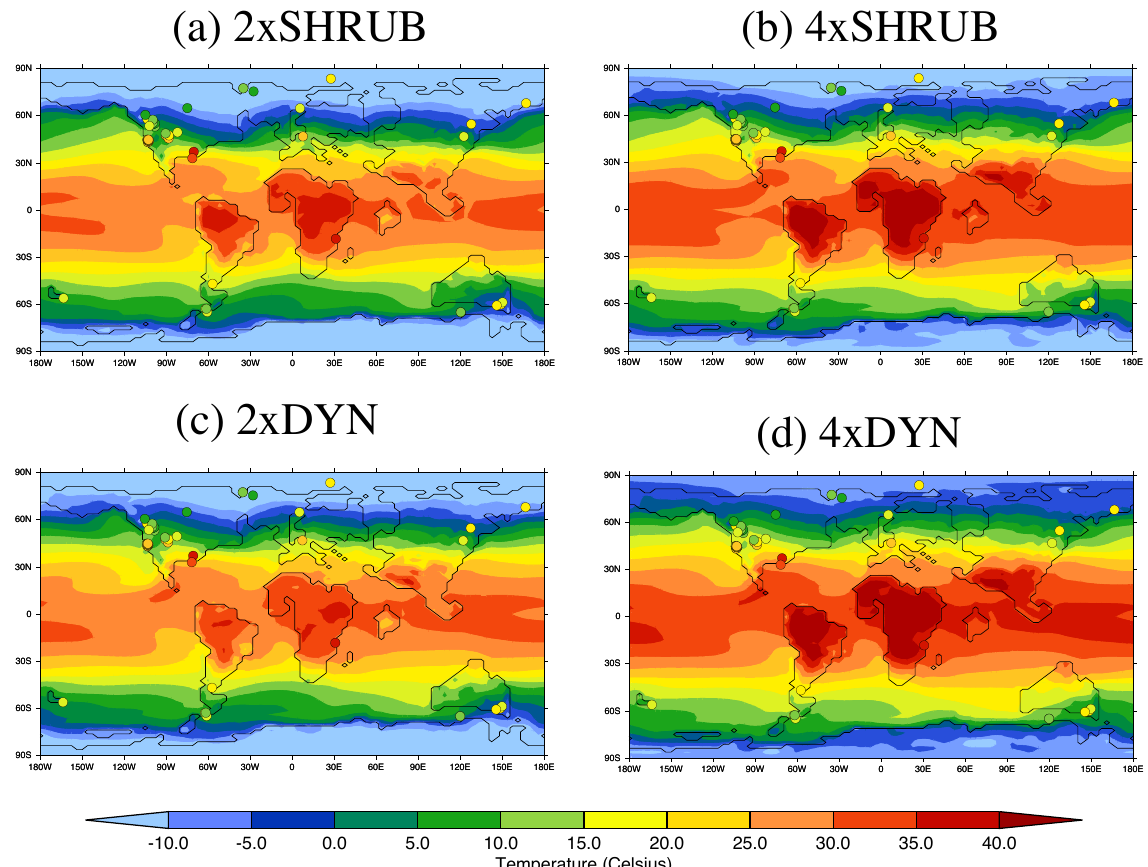
Fig. 6. Comparison of modelled global annual mean 2m surface air temperature with temperatures inferred from proxy data. The circles show the temperature inferred from proxy data at the point where the data were collected. Data set from Huber and Caballero (2011), Pross et al. (2012) and Wolfe et al. (2012).